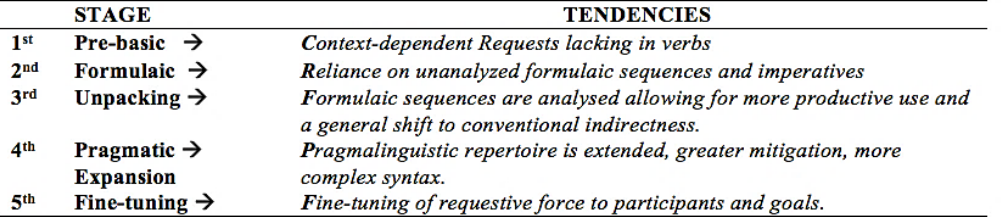
FIGURE 9 Five stages of L2 Request Development Adapted from Kasper and Rose (2002, p.